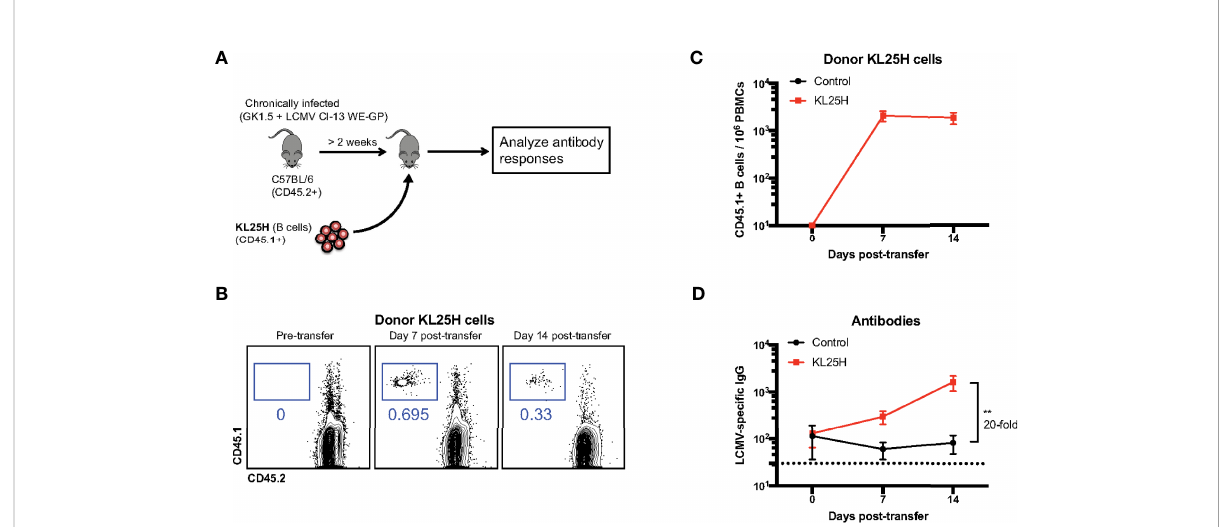
FIGURE 1 Transfer of virus-speci fi c B cells improves antibody levels in chronically infected mice. (A) Experimental outline for evaluating the effect of B cell transfer during a chronic viral infection. Mice chronically infected with LCMV Cl-13 WE-GP received 5x10 6 KL25H B cells. (B) Representative FACS plots showing the frequencies of KL25 B cells in blood. (C) Summary of KL25H B cells in blood. CD45.1 expression was used to distinguish donor cells. (D) Summary of virus-speci fi c antibody levels in sera by enzyme-linked immunosorbent assay (ELISA). Experiments were repeated 5 times, n=3-5 mice per group per experiment. Error bars represent SEM. The p-values were calculated using Mann-Whitney test. ** P <0.005. Dotted line represents limit of